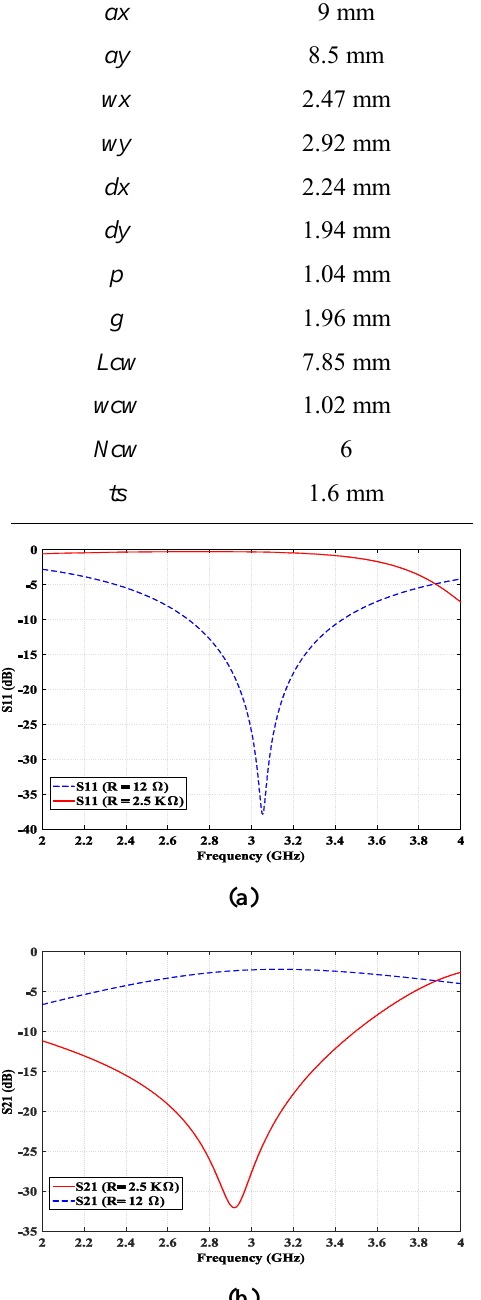
Figure 3: Simulated reflection (a) and transmission (b) characteristics of the structure for two states of the diodes.